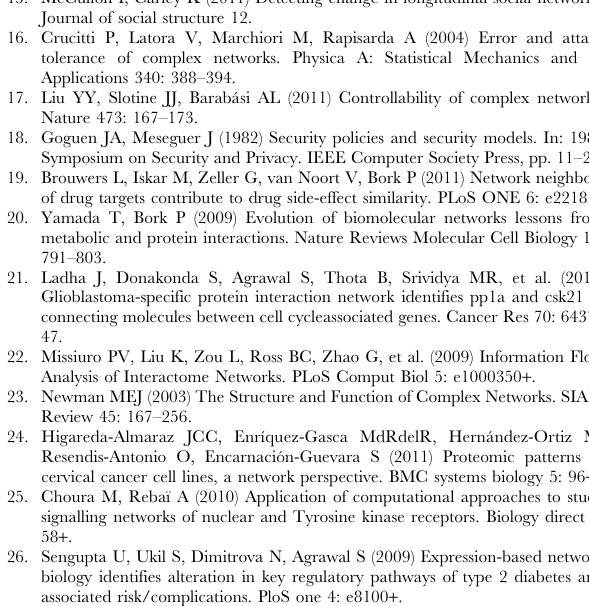
Table S2 Average and Max Interference values for the integrin activation